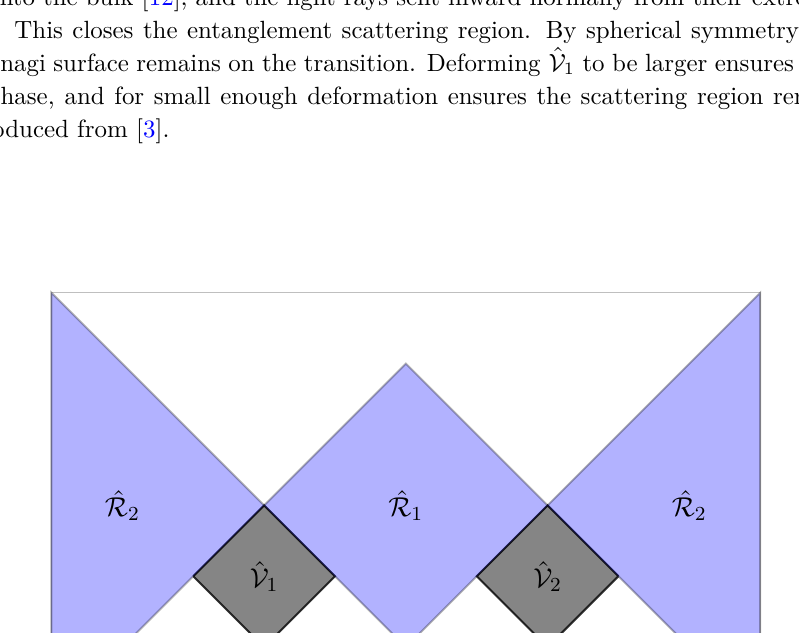
Figure 4. A typical choice of regions which leads to a non-trivial conclusion in the connected wedge theorem 4. Region ˆ R two wedges which each extend to